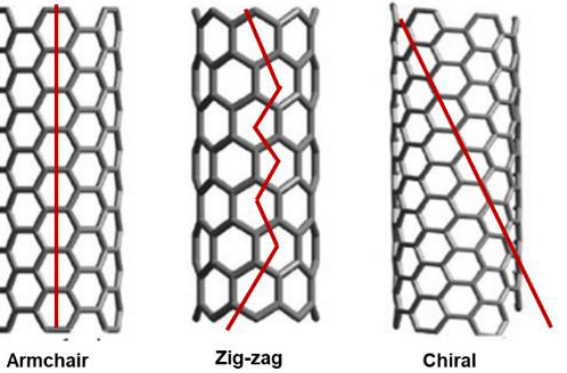
Figure 9. Armchair, zigzag, and chiral structures of SWCNTs. This images by unknown author are licensed under CC